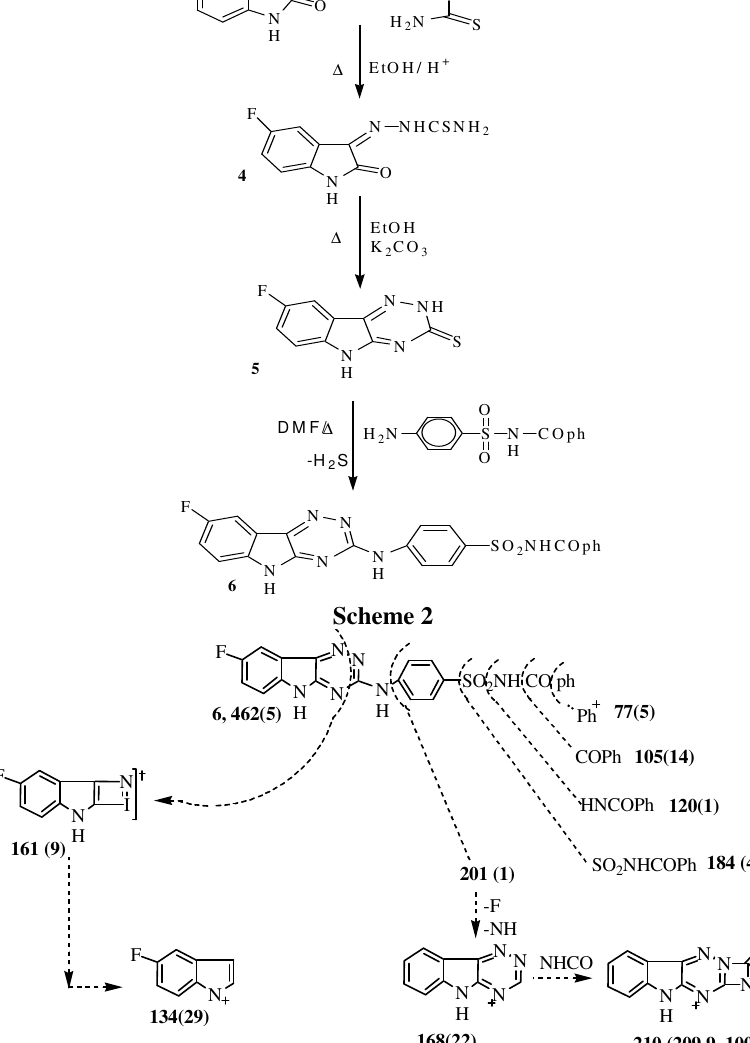
Figure 2. Mass fragmentation pattern of compound